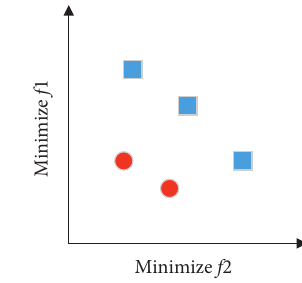
Figure 9: The Pareto dominance